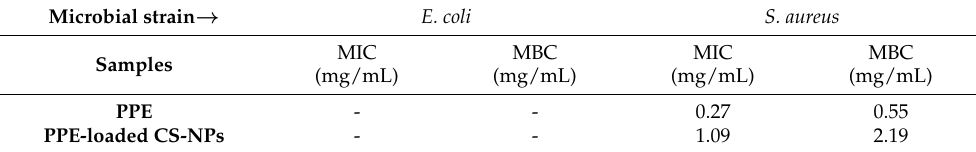
Figure 6. Results of antimicrobial test against E. coli and S. aureus using resazurin-aided microdilution method performed in 96-well microtiter plates. Samples: ( a ) PPE, ( b ) empty CSNPs, ( c ) PPE-loaded CSNPs (chitosan:PPE ratio of 1:5.00 w/w ). Sample concentrations for well columns 1–10 are reported in the figure. Table 5. MIC and MBC results of pure PPE and PPE-loaded CSNPs (at chitosan:PPE ratio of 1:0.50 w / w ) against E. coli and S. aureus